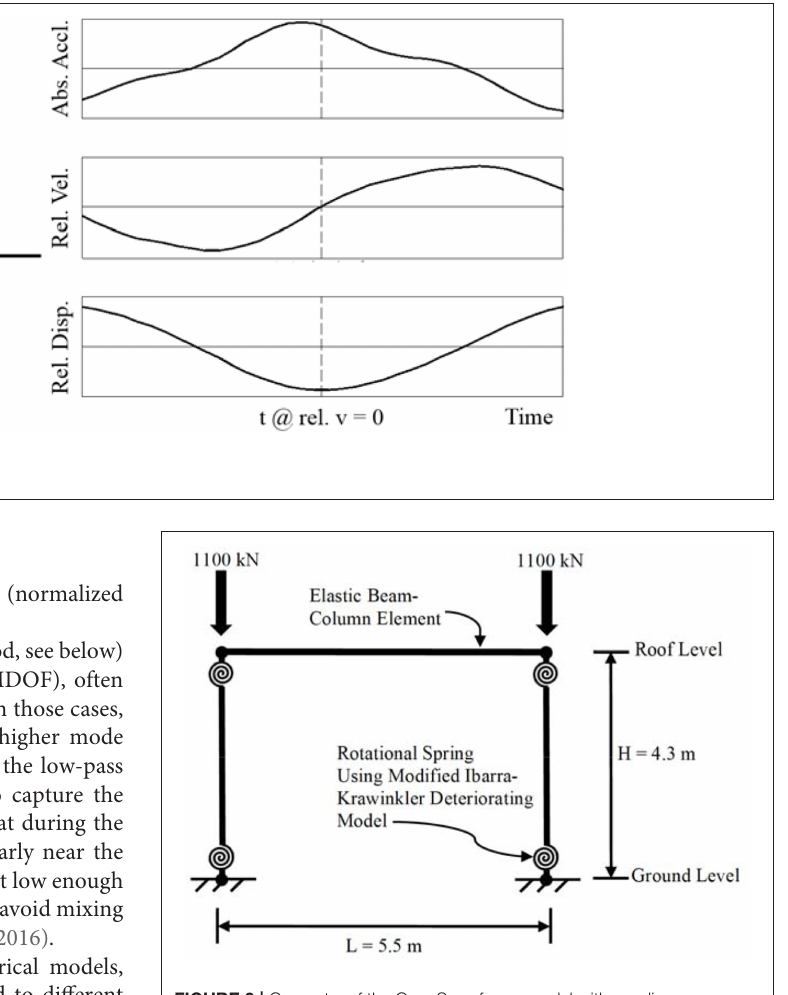
FIGURE 2 | Geometry of the OpenSees frame model with non-linear rotational